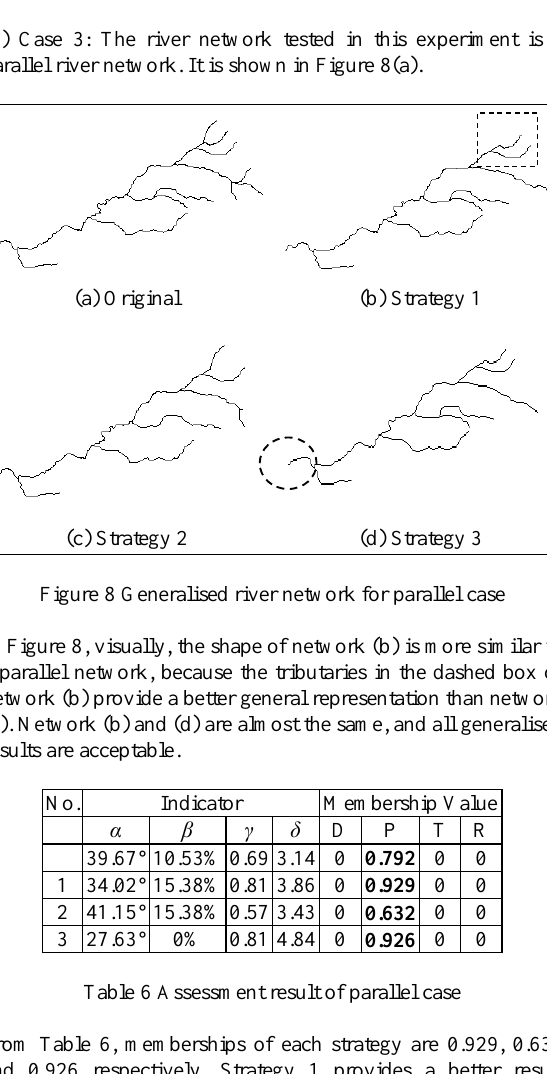
Figure 7 Generalised river network for trellis case